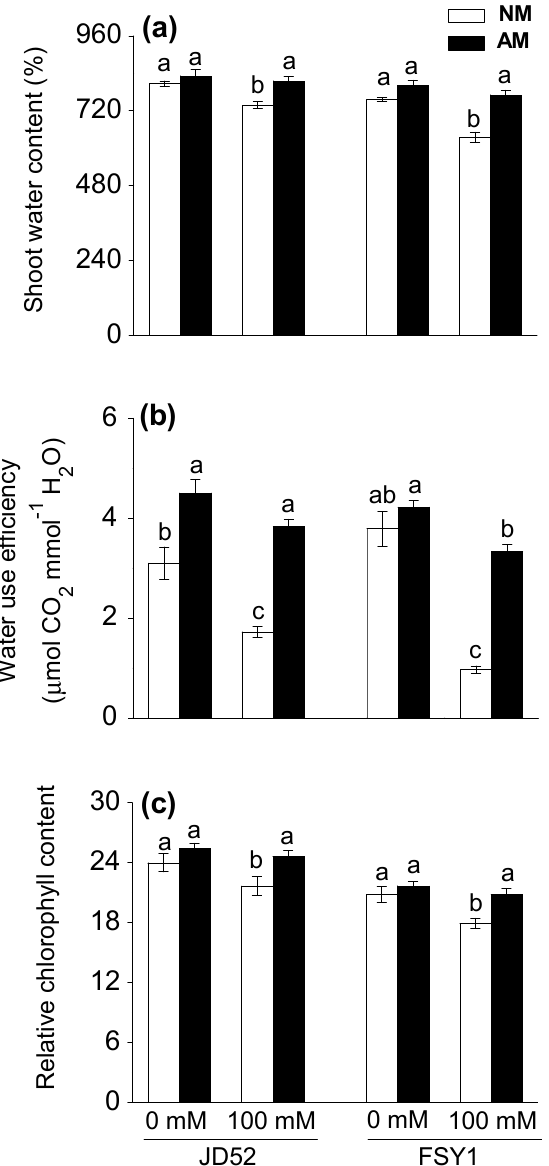
Figure 1. Relative water content ( a ), water use efficiency ( b ), and relative chlorophyll content ( c ) in two maize genotypes (JD52 and FSY1) inoculated with Funneliformis mosseae (AM) or without inoculation (NM) in 0 and 100 mM NaCl treatments assessed at 59 DAS. For each trait, bars with different letters indicate significant differences ( p ≤ 0.05).